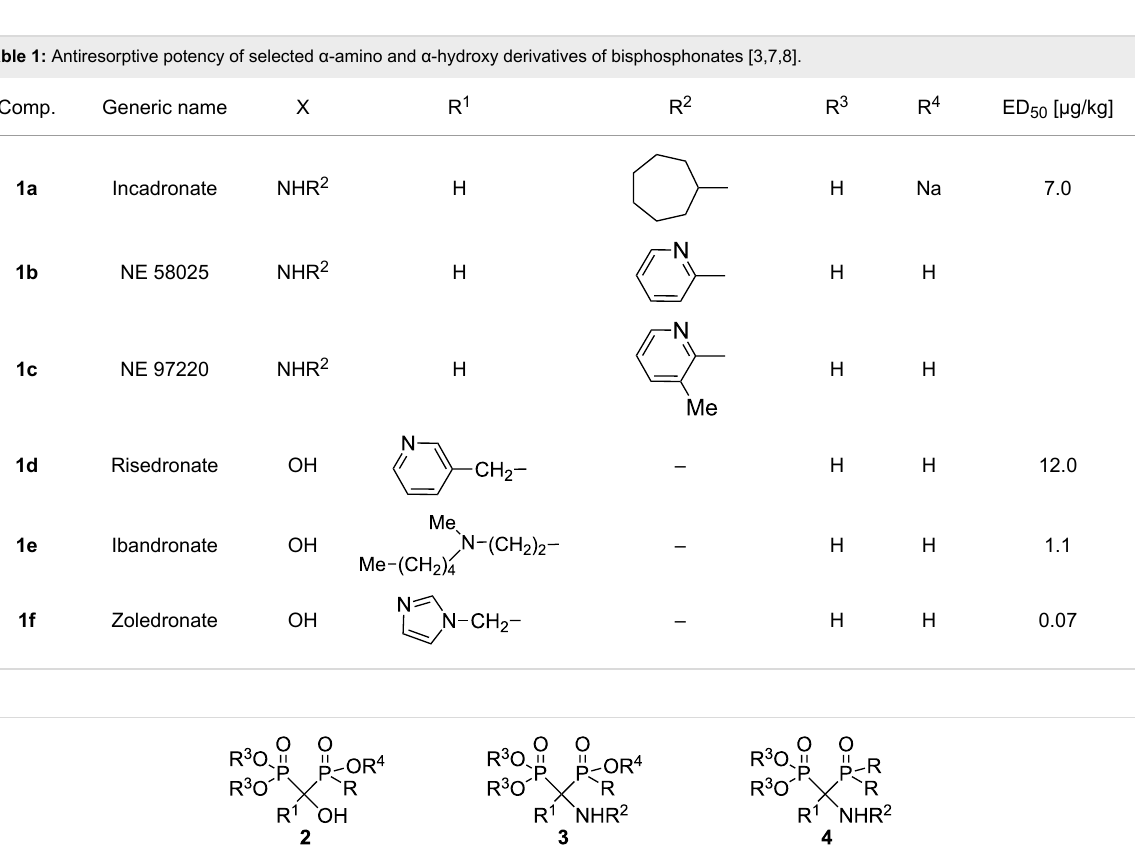
Figure 2: General structures of 1-hydroxy- and 1-amino-1-phosphinylalkylphosphonates ( 2 and 3 , respectively) and 1-amino-1-phosphinoylalkylphos- phonates 4 .